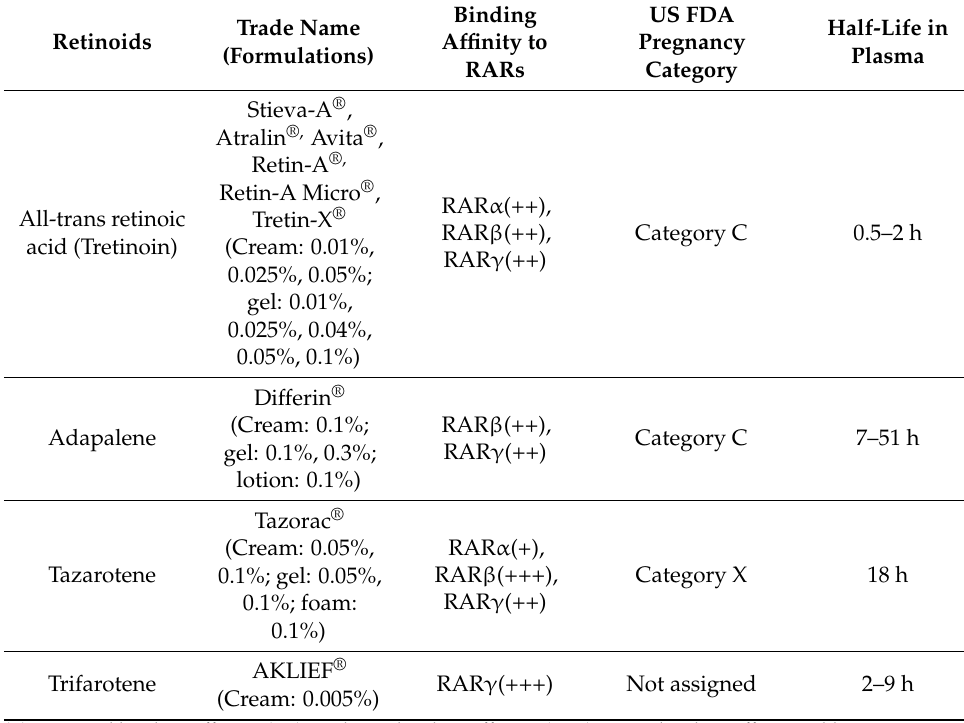
Table 3. Summary of topical retinoids for